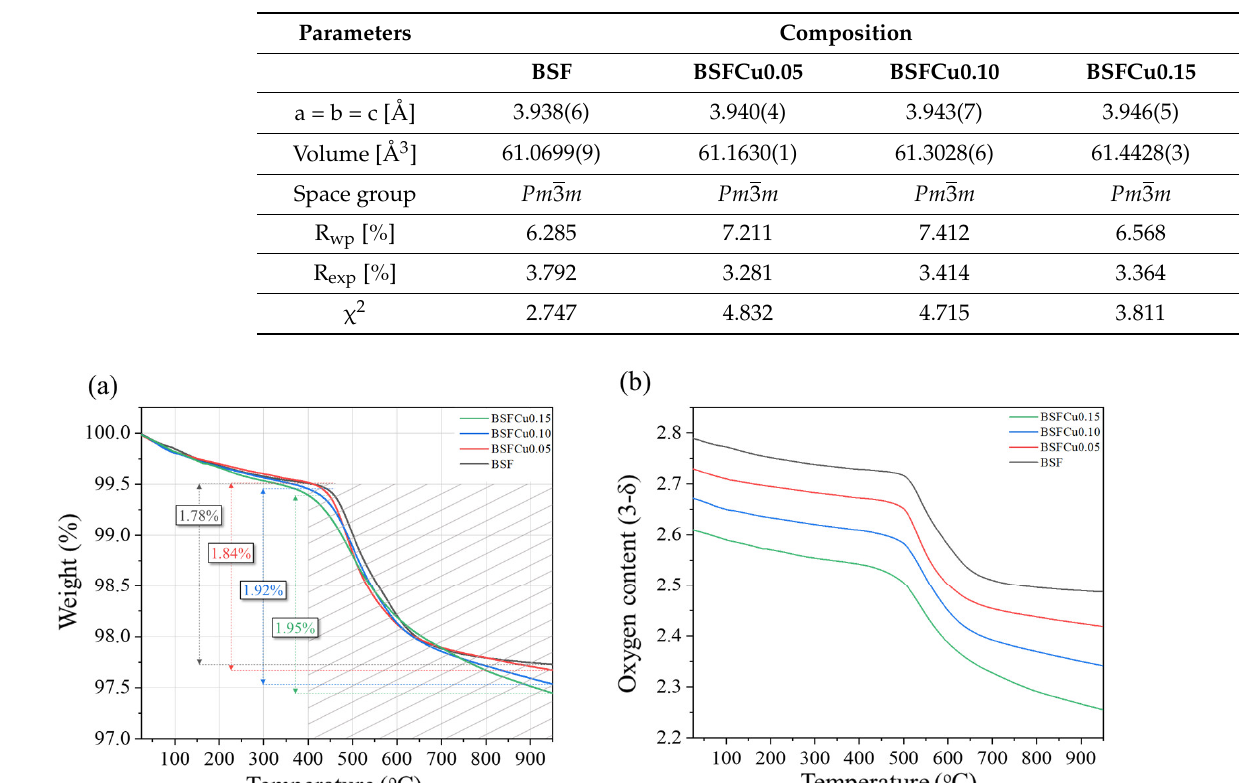
Table 1. Structural parameters of the Ba 0.5 Sr 0.5 Fe 1 − x Cu x O 3 − δ (x = 0, 0.05, 0.10, 0.15) calculated by Rietveld refinement of the room-temperature XRD